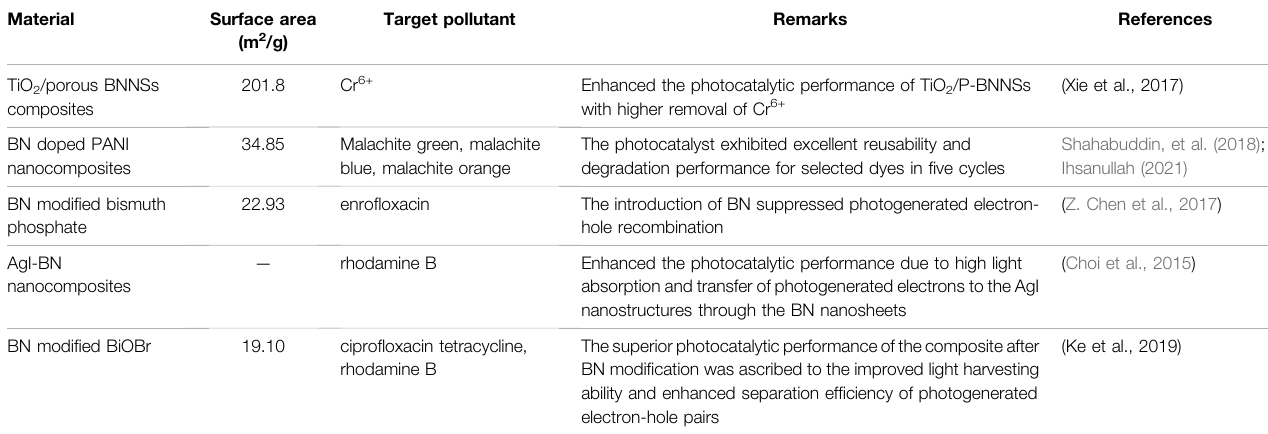
TABLE 4 | Scope of different BN based materials for water puri fi cation via photocatalysis. Material Surface area (m 2